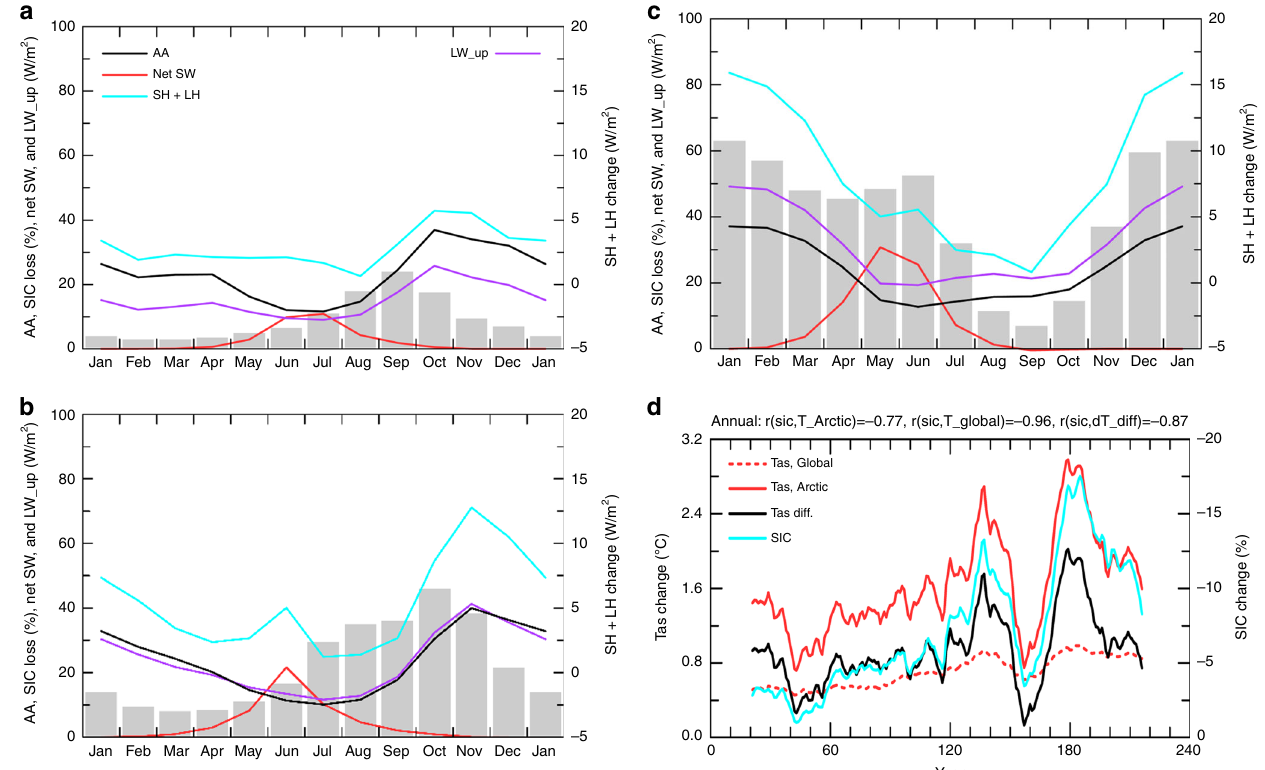
Fig. 7 Centennial changes as a function of month from CESM1 standard simulation with a 1%-per-year CO 2 increase. Same as Fig. 3, except for the change during the a fi rst (year 61 – 80 mean minus control climatology), b second (year 131 – 150 mean minus year 61 – 80 mean), and c third (year 201 – 220 mean minus year 131 – 150 mean) CO 2 doubling from the standard simulation with a 1% CO 2 increase per year using the CESM1. d Time-dependent warming and sea-ice loss from CESM1 simulation with a 1%-per-year CO 2 increase. Same as Fig. 3d except for the CESM1 1% CO 2